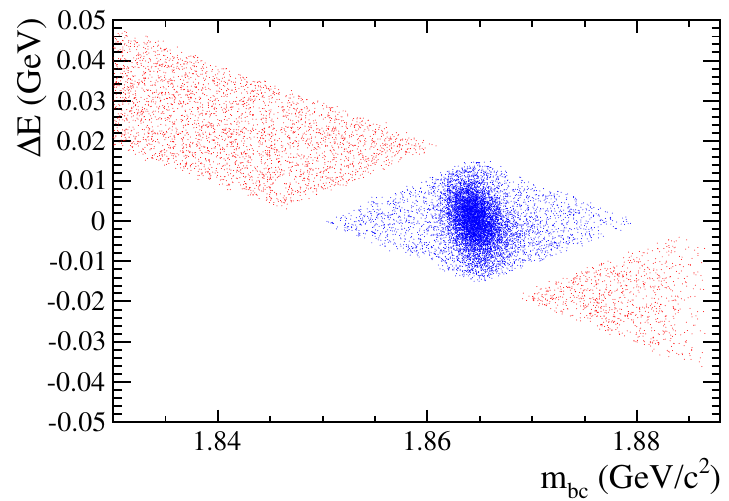
Figure 2 . Distribution of D 0 ! (cid:25) + (cid:25) (cid:0) (cid:25) + (cid:25) (cid:0) candidate events in missing energy (cid:1) E and beam constrained mass within the selection regions, which are bounded by the annulus of constant in- variant mass and lines normal to it. The central region (blue) is de(cid:12)ned as the signal region, with sideband regions (red) providing background samples.